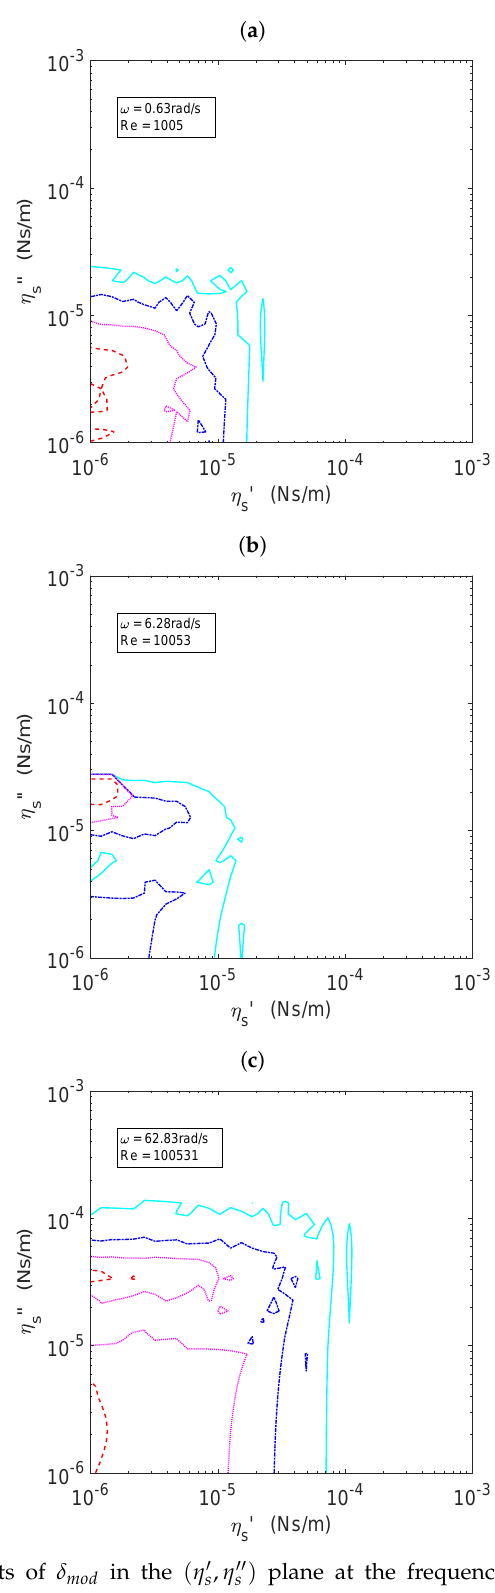
Figure 5. Contour plots of δ mod in the ( η (cid:48) s , η (cid:48)(cid:48) s ) plane at the frequency value indicated in the corresponding legend. The contour lines correspond to the following percentage values of δ mod : ( a ) 0.01, 0.02, 0.04, 0.1; ( b ) 0.15, 0.3, 1, 30; ( c ) 0.2, 0.5, 1, 2. In the three graphs, red dashed lines correspond to the highest δ mod value and continuous light blue lines to the lowest δ mod